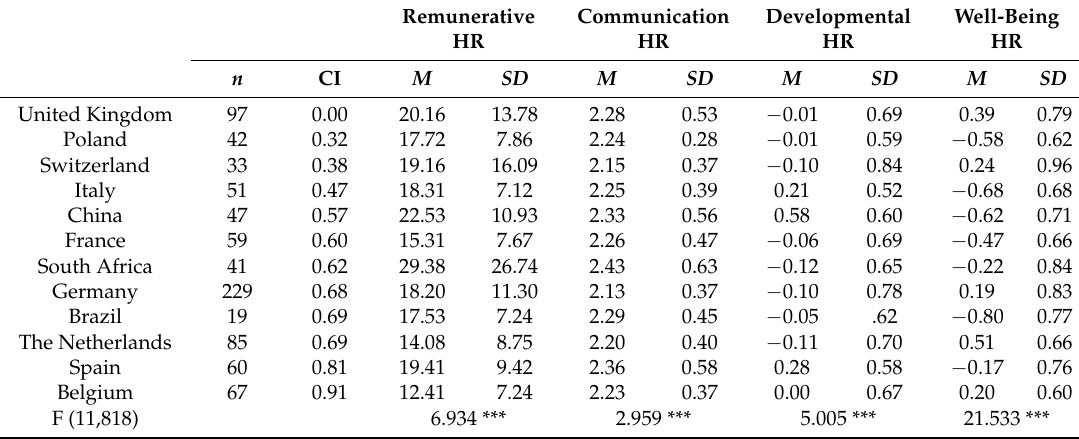
Table 1. Coordination Index and Human Resources Management (HRM) Practices across Countries.